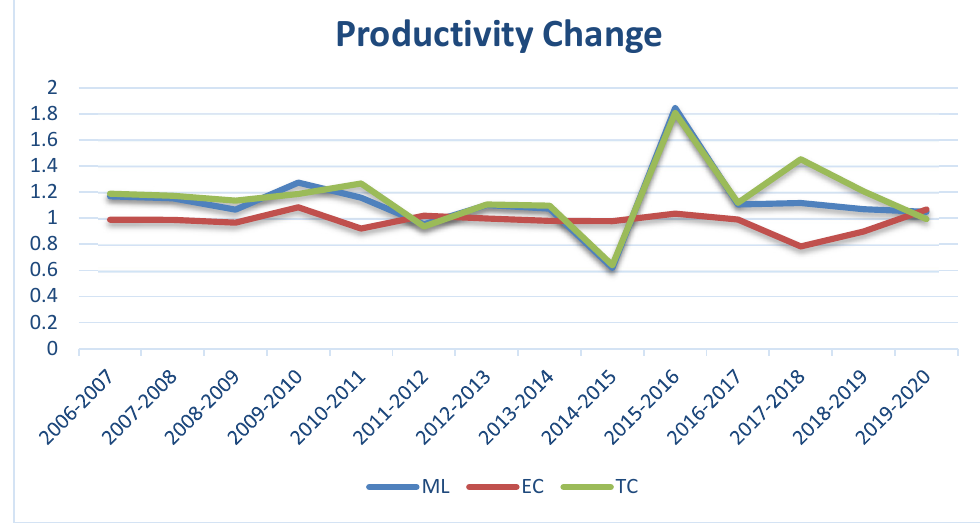
Figure 5. Average Malmquist–Luenberger index change, efficiency change, and technological change in Chinese provinces (2006–2020).